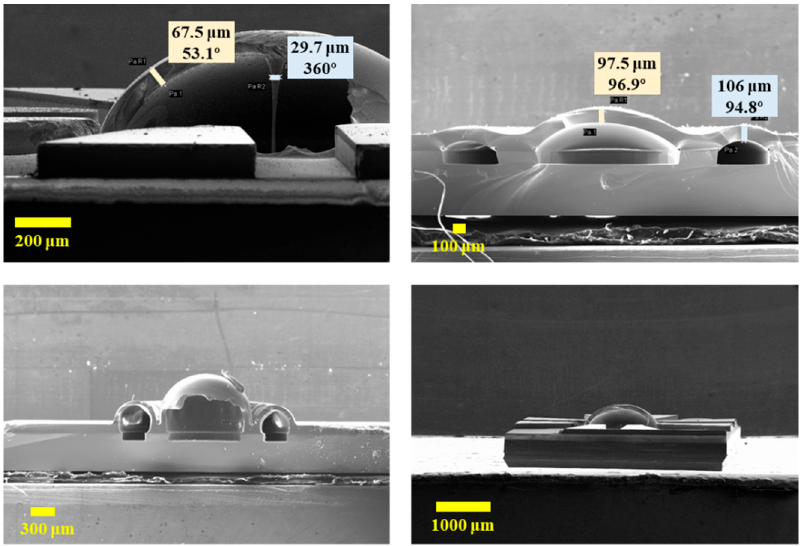
Figure 11. SEMs of broken hemispherical shells.